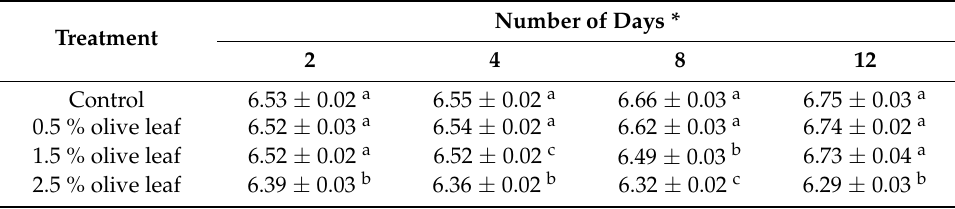
Table 1 . Effect of the olive leaf extract on pH values of the sheep meat slide. Table 1. Effect of the olive leaf extract on pH values of the sheep meat